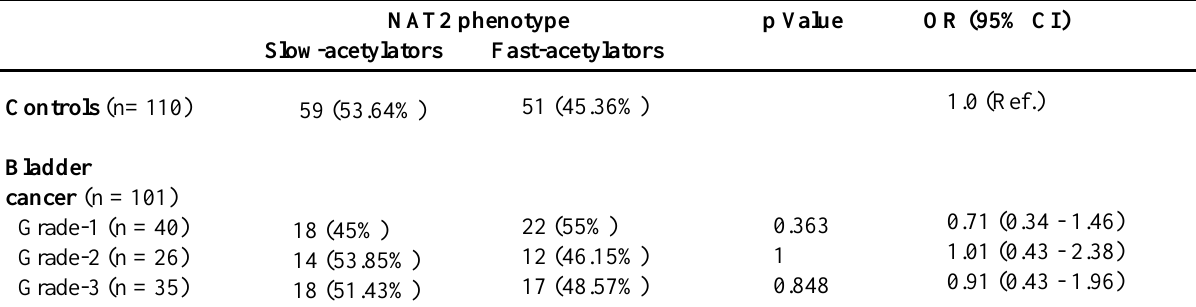
Table 4 – Frequency of N-acetyltransferase-2 genotypes of bladder cancer patients categorized by pathologic grade of